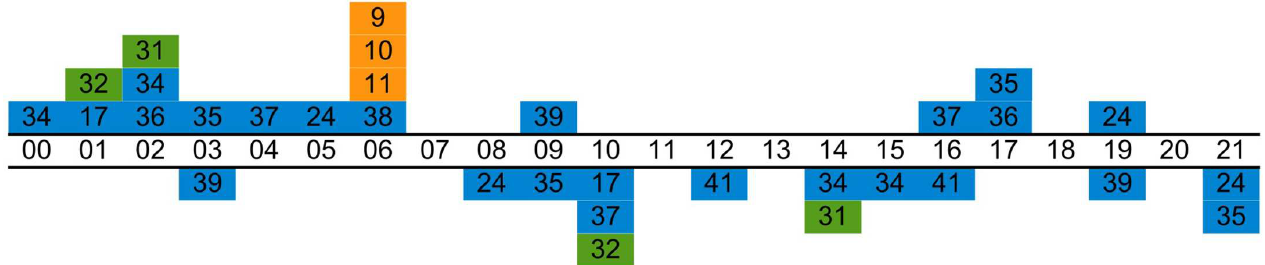
Fig 1. Estimatesof phase reported in earlier literature. Every count represents one claim of havinglocated a peak (box above time-line) or a trough (box belowtime-line)in a dataset. Blue: Studies includedin quantitative review. Green: Studies not includedin quantitative review. Orange: Meta-analysis. Review papersare not